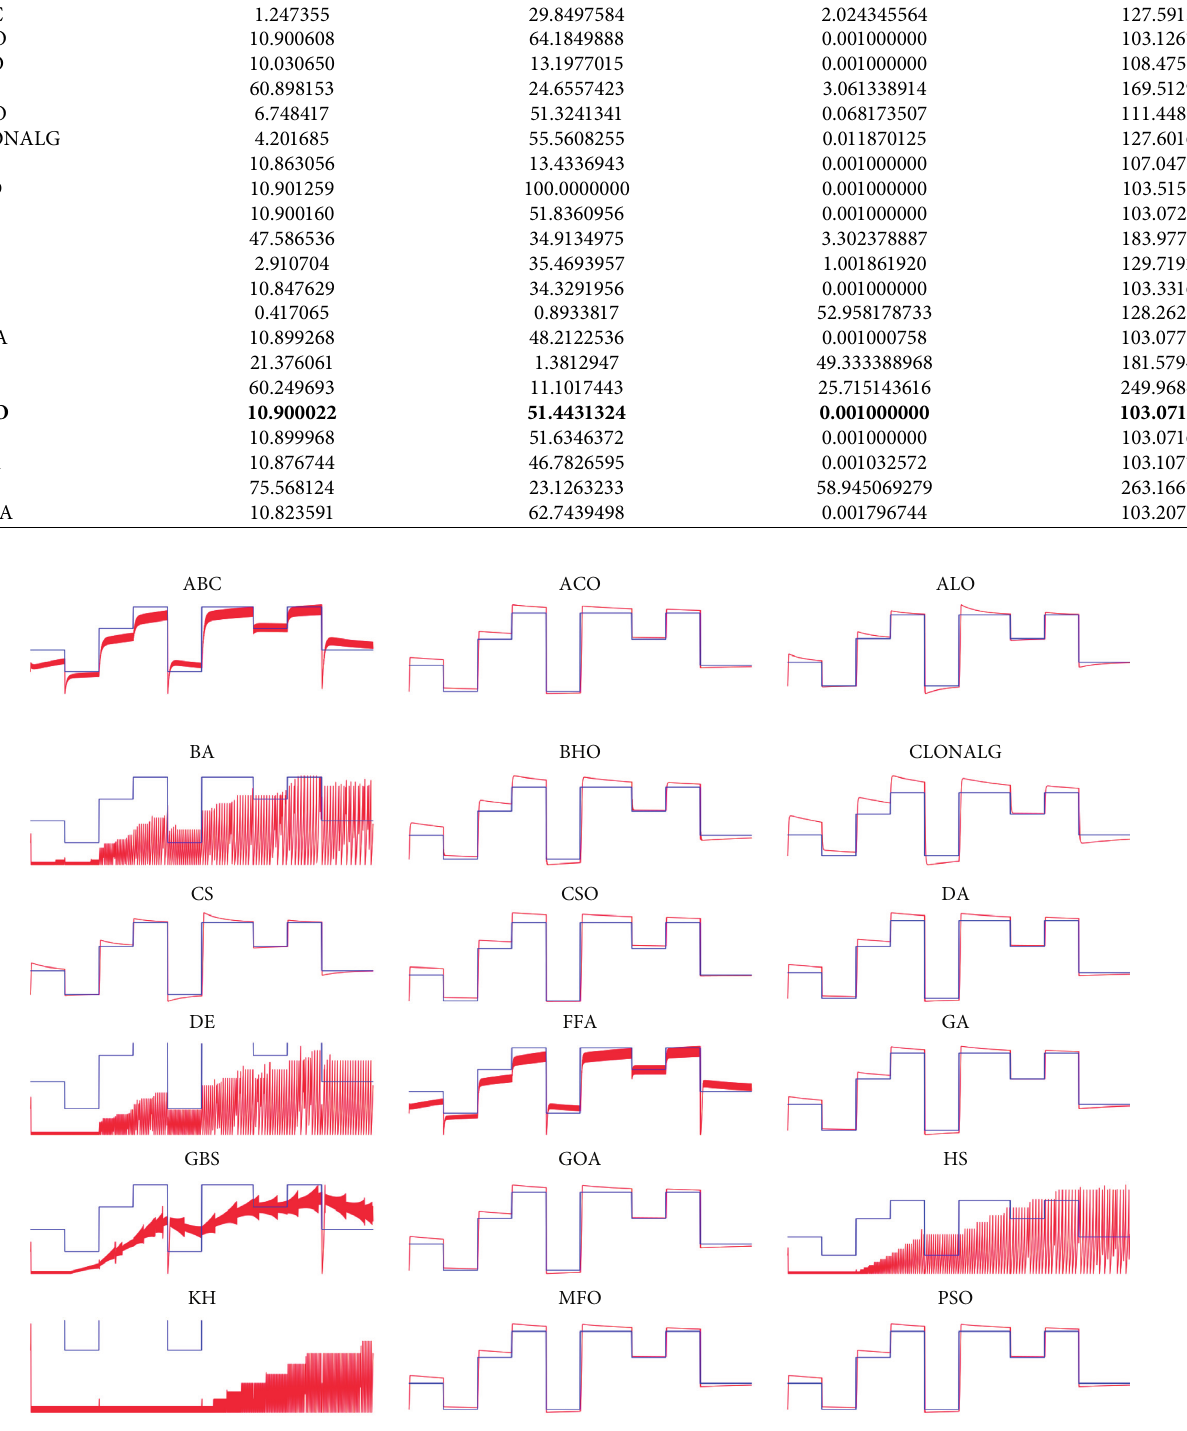
, see equation (2) and Figure 6.